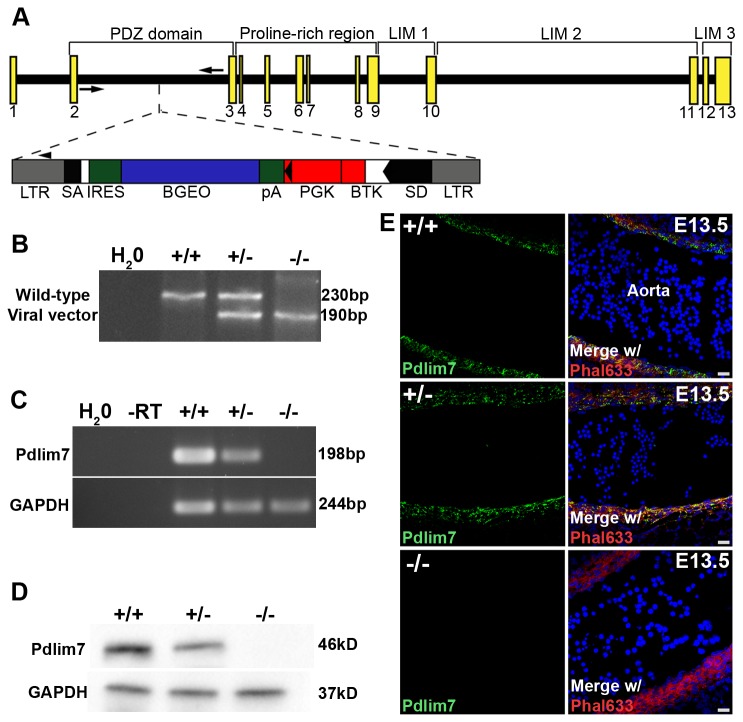
Generation of Pdlim7 mutant mice.Schematic representation of the retroviral integration site within intron two of the Pdlim7 gene (A). Exons are depicted by yellow boxes with WT and viral-specific genotyping primers represented by arrows and an arrowhead, respectively. Genotyping reveals a 230bp PCR fragment representing the WT allele and a 190bp product for the viral integration (B). Semi-quantitative RT-PCR demonstrates absence of Pdlim7 gene transcripts in adult uteri of Pdlim7-/- mice using GAPDH as control (C). Western blot shows that Pdlim7-/- and Pdlim7+/- mice express only -1.18 ± 2.64% and 29.36 ± 14.92% Pdlim7 protein compared to WT controls, respectively (D). Sagittal section through the aorta demonstrates Pdlim7 antibodies (green) localize to filamentous actin (red) of smooth muscle in WT, but not Pdlim7-/- embryos (E), further verifying loss of Pdlim7 protein in null mice (control DAPI nuclei, blue). LTR = long terminal repeat; SA and SD = splice acceptor and donor sites, respectively; IRES = internal ribosomal entry site; BGEO = lacZ gene; pA = polyadenylation signal; PGK = phosphoglycerate kinase gene; BTK = Bruton’s tyrosine kinase gene.